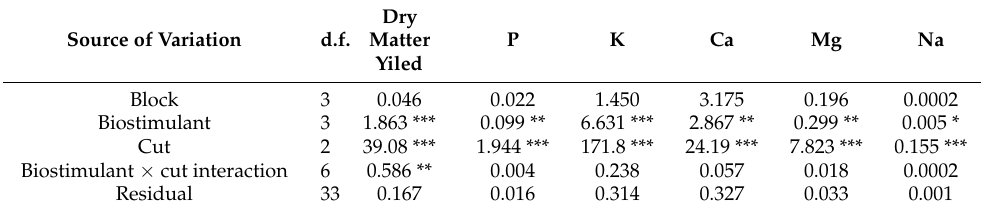
Table 1. Mean squares from two-way analysis of variance for six observed traits. Source of Variation d.f.